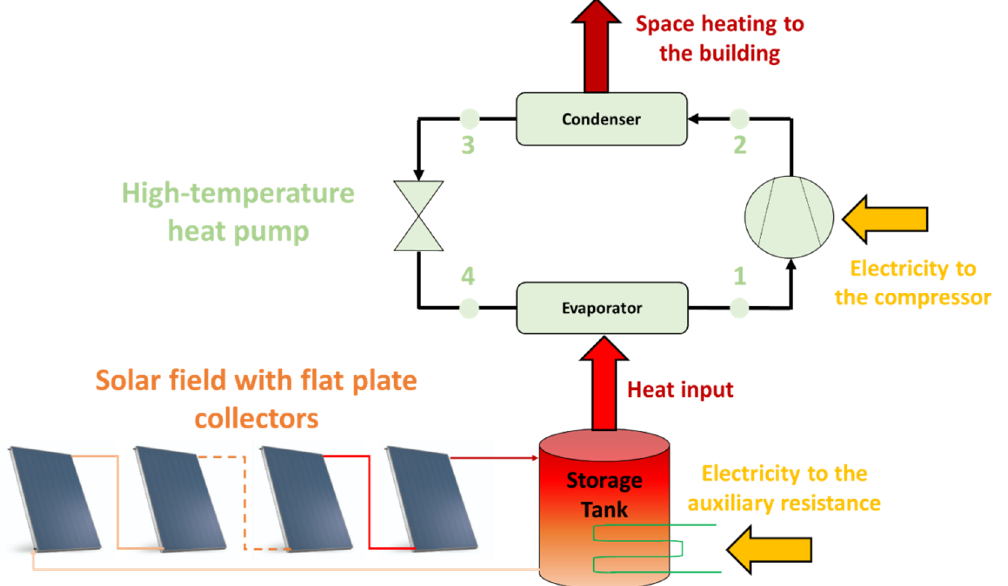
Figure 1. The examined system with a solar-assisted heating unit which includes a solar field, a thermal storage tank with auxiliary electrical resistance and a high-temperature heat pump.